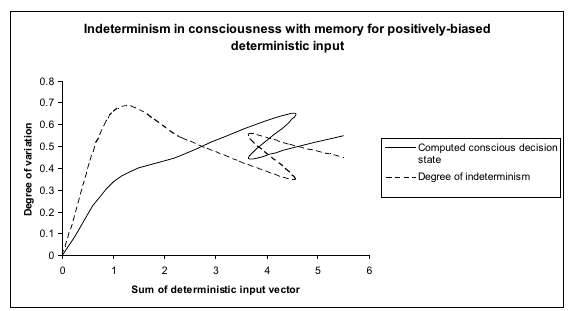
Fig. 18. Variation of state of consciousness in system with memory (+biased C1).